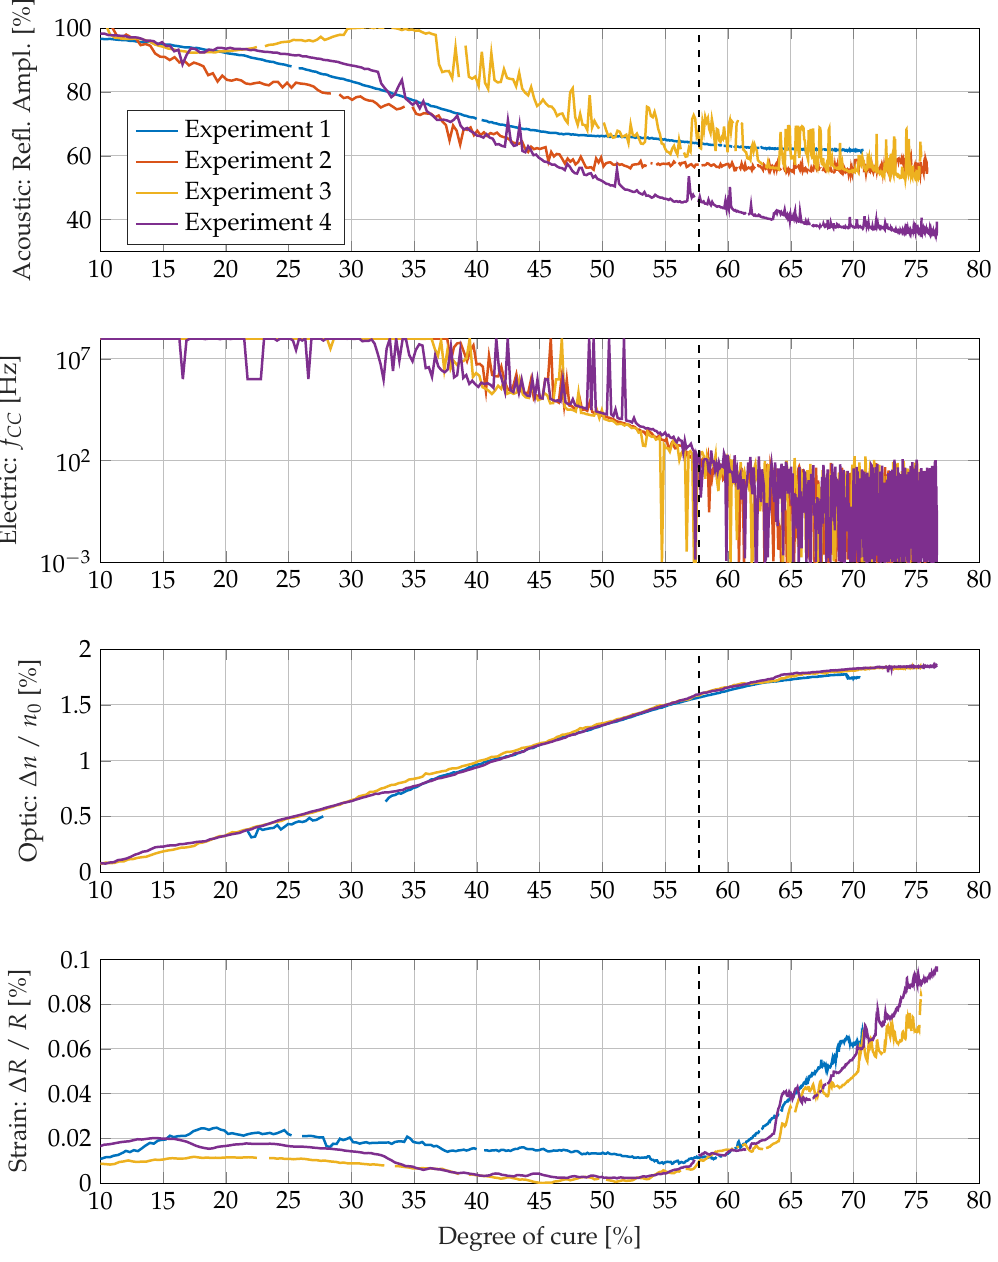
Figure 13. Sensitivity of different measurement parameters and derived variables for the degree of cure in different cure stages. The gelation point is shown at 57.7% degree of cure according to Flory